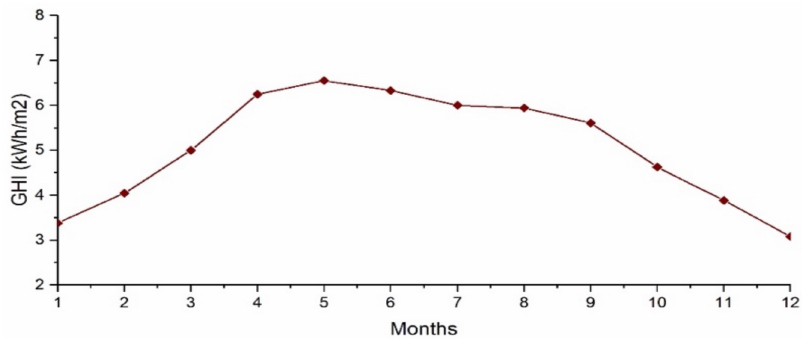
Figure 6. Monthly mean daily GHI of Multan,